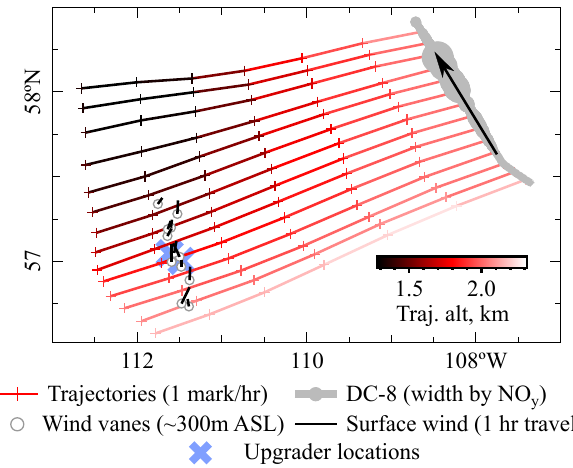
Figure 13. Low-altitude winds and back trajectories to the DC-8 flight track on 29 June. Kinematic back trajectories are from the Florida State University group and are driven by hourly FSU/WRF winds on a 45km grid initialized from GFS. Surface winds are from ground stations at about 5h before the DC-8